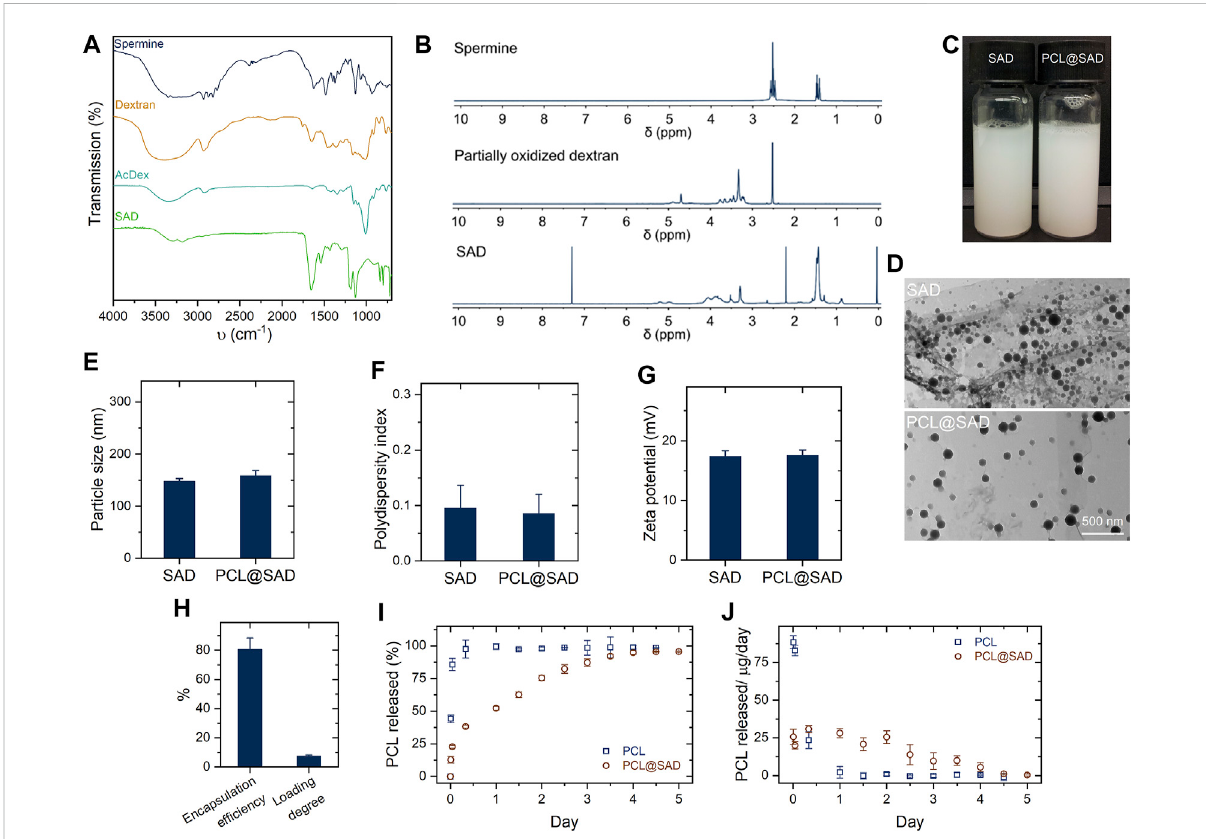
FIGURE 1 CharacterizationofSADnanoparticles. (A,B) TheFouriertransforminfrared (A) andnuclearmagneticresonance (B) spectraofdextranandSAD. (C,D) Representative photos (C) and transmission electron microscopy images (D) of bare SAD nanoparticles and PCL@SAD nanoparticles. (E – G) Average particle size (E) , polydispersity index (F) , and zeta potential (G) of the engineered nanoparticles ( n = 3). (H) Encapsulation ef fi ciency and loading degree of PCL in SAD nanoparticles ( n = 3). (I,J) Cumulative PCL release pro fi les (I) and daily amount of PCL released (J) from PCL and PCL@SAD ( n =